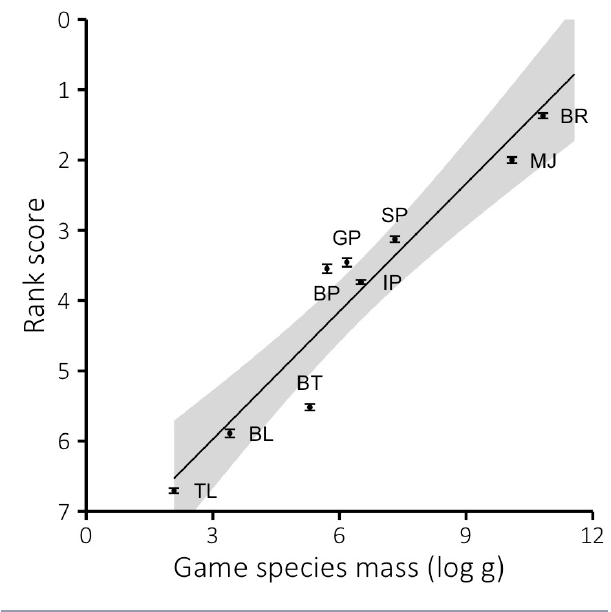
Fig. 2 . Hunters preferred larger game species. A linear model was fit between rank score and the focal taxa’s mass (log- transformed), and the grey band corresponds to the 95% confidence interval. The points and associated error bars show the average rank (and standard error of the mean) for the focal taxa. The game species masses are provided in Appendix 1, Table A4. The abbreviated labels represent the following: BR, boar; MJ, muntjac; SP, Silver Pheasant ( Lophura nycthemera ); GP, Grey Peacock-Pheasant ( Polyplectron bicalcaratum ); IP, Imperial Pigeon ( Ducula spp.); BP, Bamboo Partridge ( Arborophila spp.); BT, Barbet ( Psilopogon spp.); BL, Bulbuls (family Pycnonotidae); and TL, Tailorbird ( Orthotomus